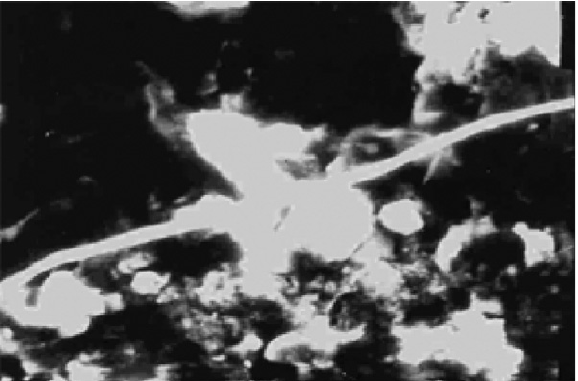
Figure 9. Microscopic photo of Y nanocomposites,1 sm= 0.5 μ m [25].